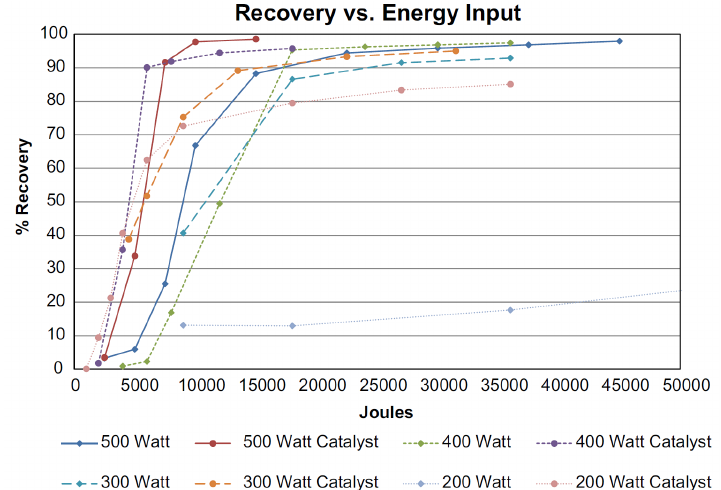
Figure 35. Comparison of oil recoveries with and without nickel particles considering different total energy inputs. Figure reproduced from Ref.